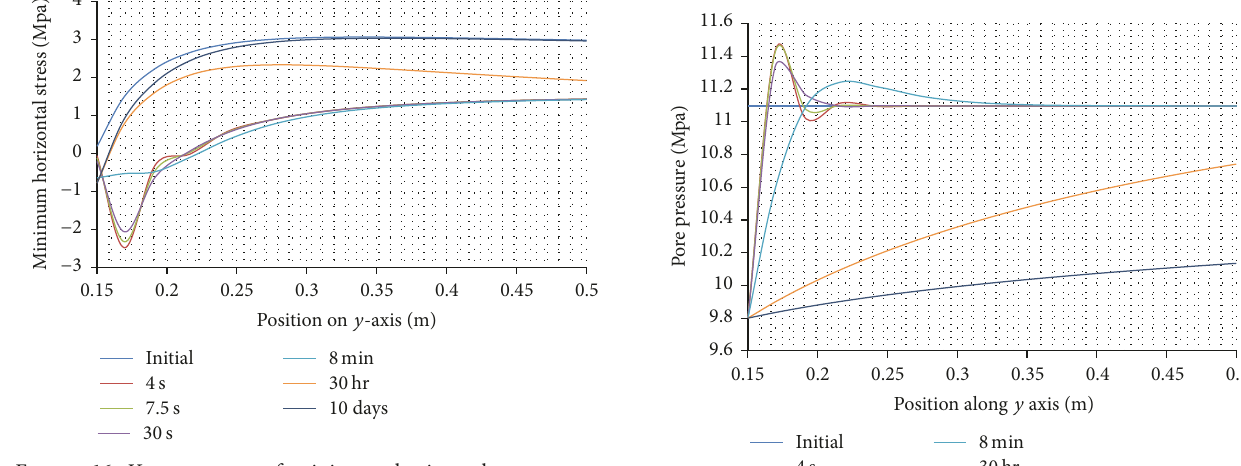
Figure 16: 𝑌 -component of minimum horizontal stresses as a function of time in poroelastic medium with 𝜎 𝐻 = 16.8MPa and 𝜎 ℎ = 14 MPa, 𝑃 𝑟 = 11MPa, 𝑃 𝑤 = 9.7 MPa, 𝑘 𝑥 = 0.01md, 𝑘 𝑦 = 0.01 md, and 𝑇 𝑚 = 300 K.